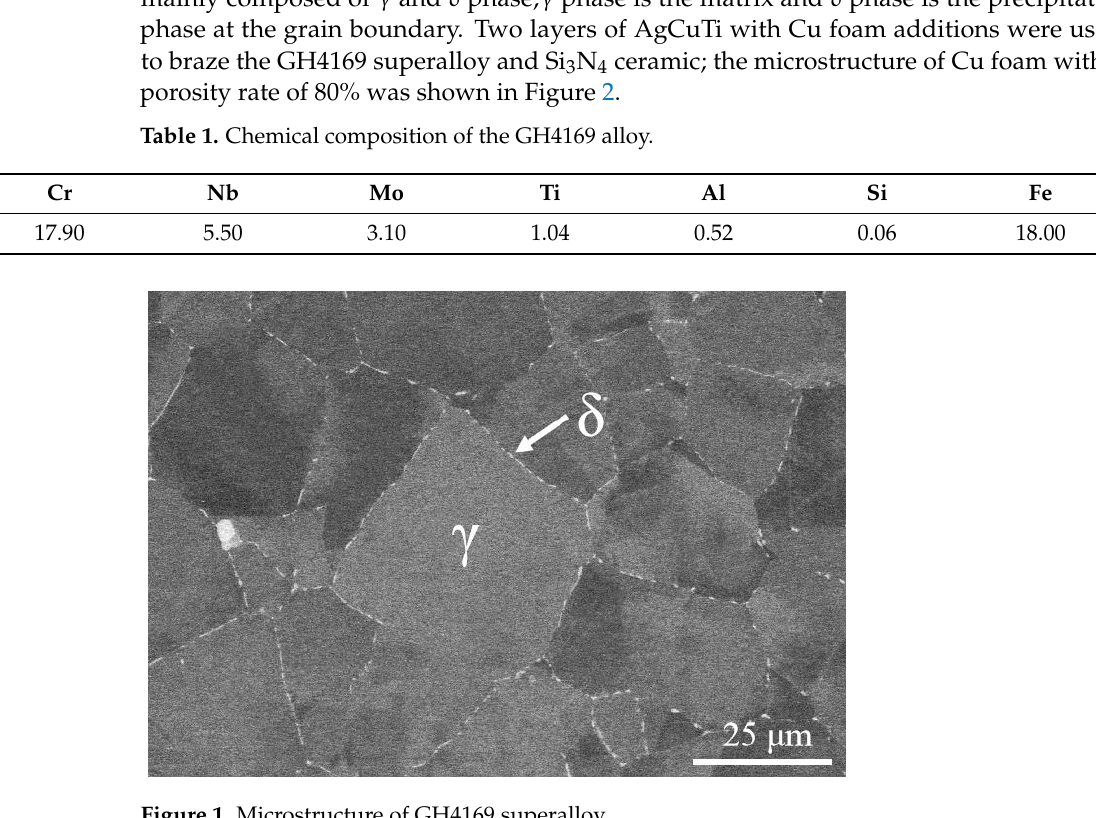
Figure 2. Microstructure of Cu foam. The AgCuTi composite filler was prepared by a mixture of Ag-28Cu and Ti powder with the mass ratio of 95.5% to 4.5%; the composite filler was ground at a speed of 100 r/min for 8 h. Before brazing, the brazing surface of GH4169 superalloy and Si 3 N 4 ceramic were ground to 2000 grit by SiC sandpapers. The AgCuTi composite filler compound and braz- ing flux were evenly mixed in a 9:1 ratio to make the solder paste, and the solder paste was applied to the surface to be brazed on the GH4169 superalloy, Si 3 N 4 ceramic, and Cu foam. The sample was stacked into a component (as shown in Figure 3a) in the manner of Si 3 N 4 ceramic/AgCuTi filler/Cu foam/AgCuTi filler/GH4169 superalloy. The whole braz- ing process is less than 8 × 10 −3 Pa vacuum brazing furnace. The samples were first heated to 400 °C at a rate of 5 °C/min, holding for 30 min, to ensure the evaporation of the brazing paste and the uniform the temperature, and then heated at a rate of 5 °C/min to the target brazing temperature (820 °C, 850 °C, 880 °C, 910 °C) for 15 min, and 5 samples were brazed at different brazing temperatures. Subsequently, the samples were cooled to room tem- perature at 5 °C/min. The thermal cycling curve of the brazing process is shown in Figure 4.